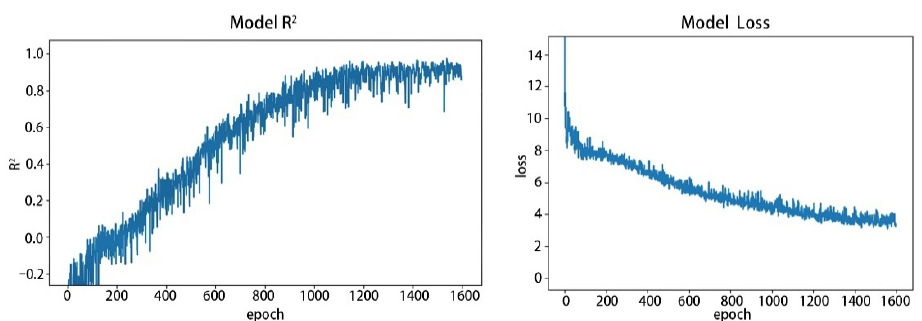
Figure 10. Model R 2 curve and Model loss curve (The R 2 and Model loss stabilizes at about 1200 epochs).